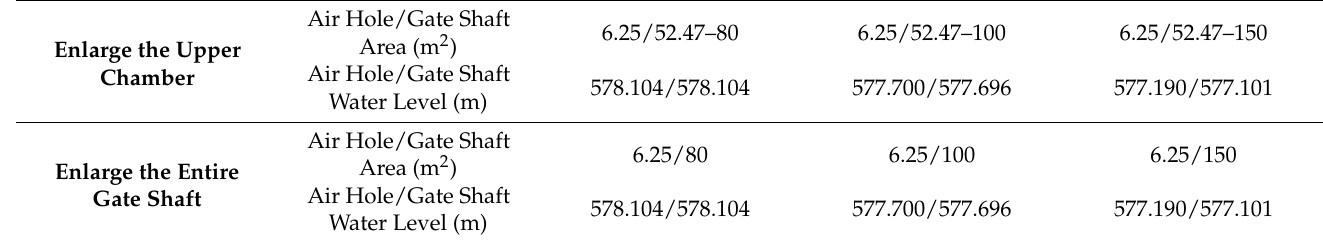
Table 4. Water level of gate shaft and air hole with different parameters of gate shaft.